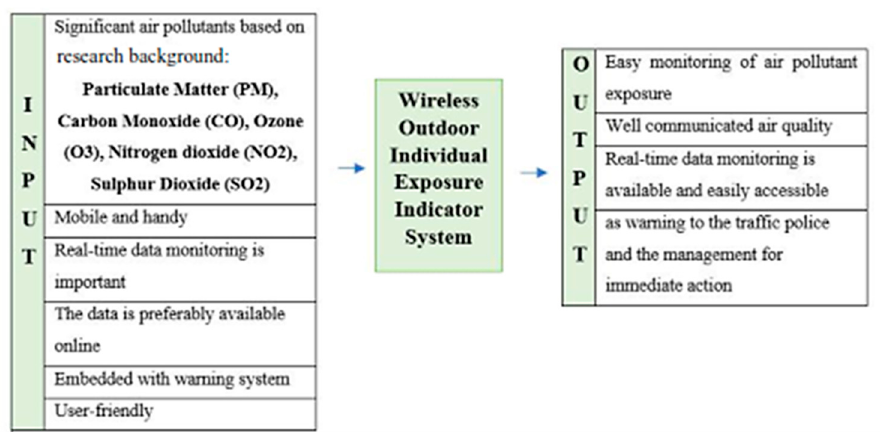
Figure 2. Criteria of the proposed system.